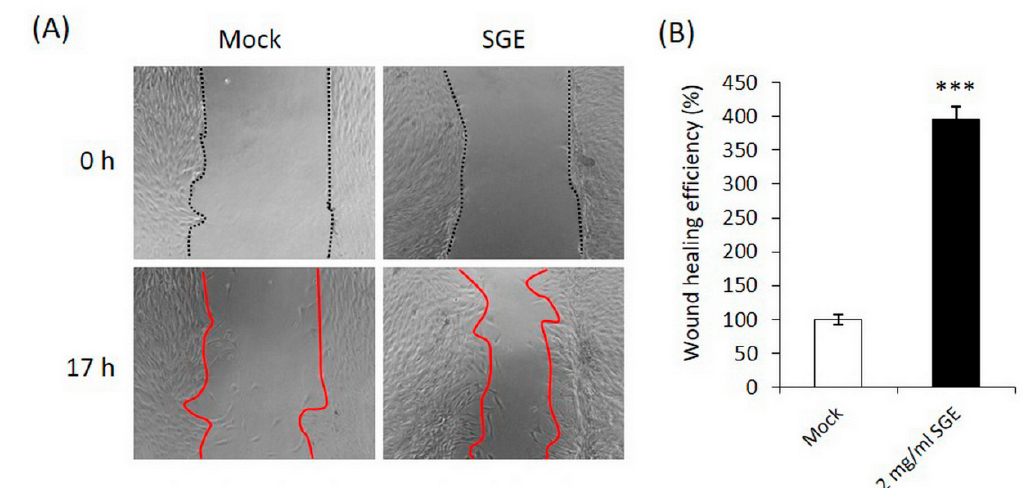
Figure 2. SGE stimulated CCD-966SK fibroblast migration in the wound healing assay. ( A ) Cells were grown to confluence and an in vitro wound was produced using a sterile pipette tip, followed by incubation with 2 mg/ml SGE or not (Mock) for 17 hours. Black dashed lines represent the initial scratch and red lines represent the migration front. ( B ) The coverage of scratch wound area in percent relative to initial wound area after a 17-hour SGE treatment (black bar) or not (Mock, white bar) was calculated. The percent of wound coverage was measured using a scan image. Histograms indicated the wound healing efficiency of 2 mg/ml SGE relative to Mock (100%). SGE, Sargassum glaucescens extracts. ***, P < 0.001 versus Mock.